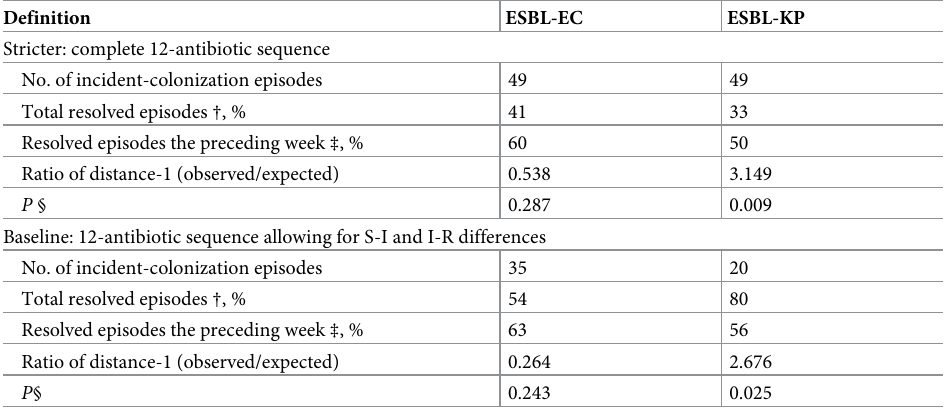
Table 2. Sensitivity analyses of transmission definition according to the stricter or baseline definition � .